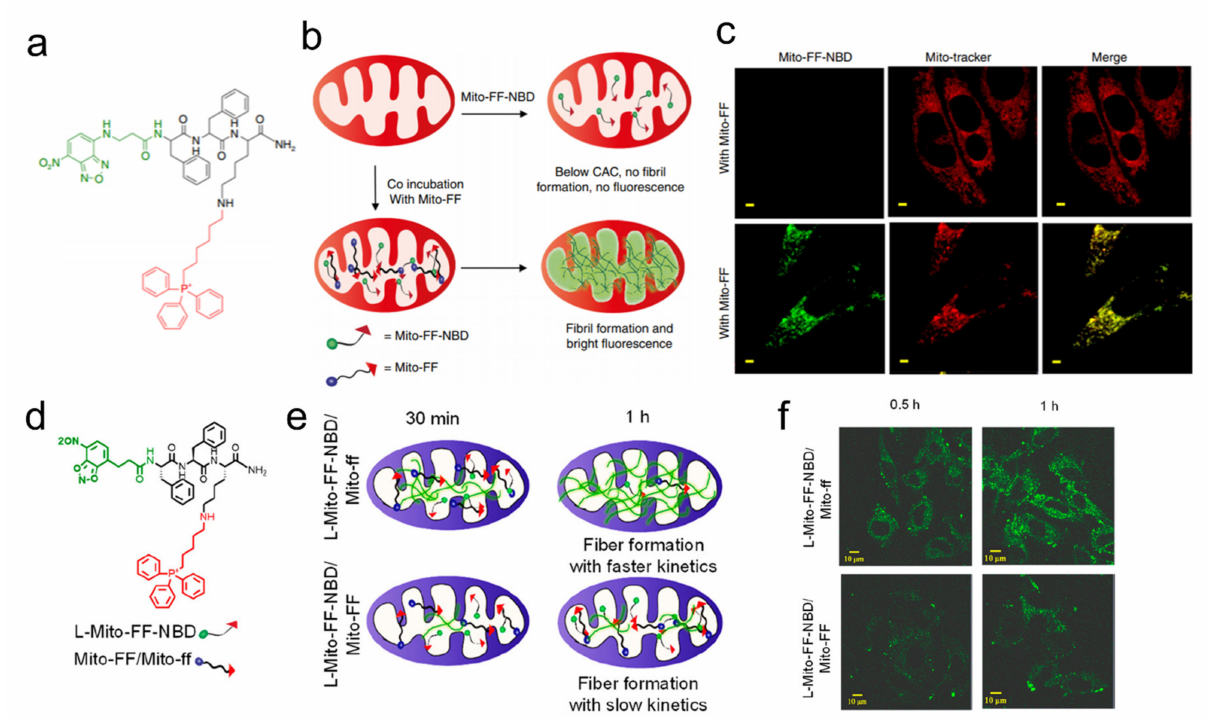
Figure 2. ( a ) Structural design of the mitochondria-targeting peptide amphiphile, Mito- FF. ( b ) Schematic diagram of co-assembly of Mito-FF-NBD with Mito-FF inside mitochondria. ( c ) Co-assembly inside mitochondria indicated by the bright green fluorescence of Mito-FF-NBD in the presence of Mito-FF. ( d ) Structural design of L-Mito-FF-NBD. ( e ) Schematic diagram of the racemic co-assembly of L-Mito-FF-NBD with Mito-ff. ( f ) Time-dependent confocal imaging after co-incubation of L-Mito-FF-NBD/Mito-FF or L-Mito-FF-NBD/Mito-ff. Adapted with permission from [50]. Copyright 2017 Springer Nature. Adapted with permission from [51]. Copyright 2019 American Chemical